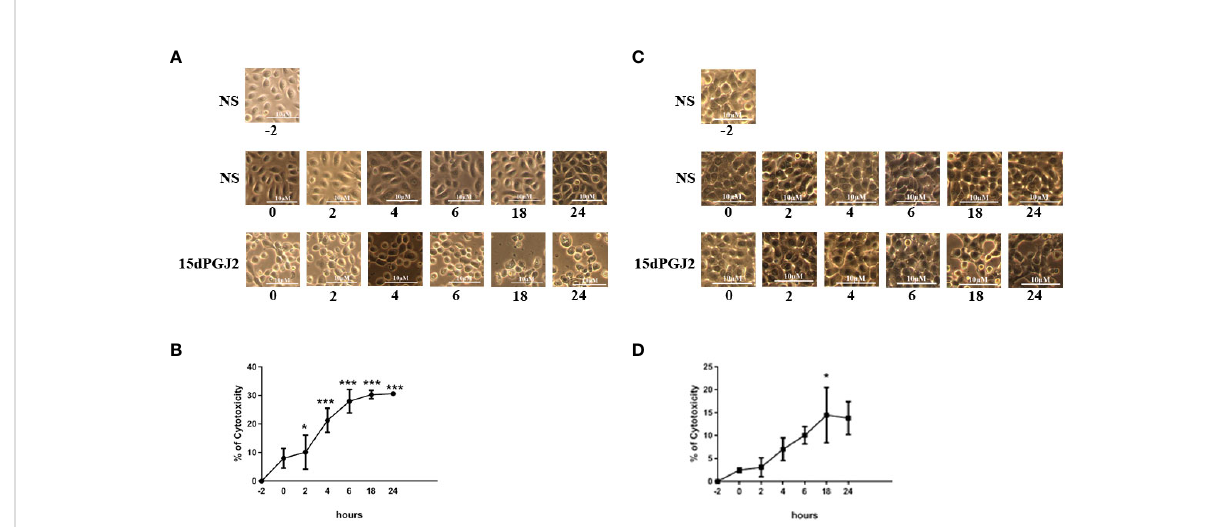
FIGURE 10 Effect of 15dPGJ2 on cell viability in vaginal and amnion epithelial cells. VECs and AECs were incubated with or without 32 m M of 15dPGJ2 and the morphology of the cells were assessed by bright fi eld light microscopy at -2, 0, 2, 4, 6, 18 and 24 hours. 15dPGJ2 or vehicle control was inserted in the corresponding wells at -2 timepoint following image and supernatant capture. The culture medium at each time point was used to detect cell viability using the MTT assay. The morphology of VECs changed from a healthy polygonal shape to an abnormal round shape compared to the control (A) . The effect of 15dPGJ2 on cell viability was detected as early as 2 hours ( p < 0.05), and a steady change was seen at 4, 6, 18 and 24 hours ( p < 0.001) (B) . In AECs, the morphological shape of the cells started to change from an ovoid, slab stone- and cobblestone-like pattern to a stretched star-like pattern at 18 hours compared to the control (C) . The cell viability of amnion epithelial cells was signi fi cantly changed by 18 hours in 15dPGJ2 treated cells ( p < 0.05) (D) . * p < 0.05, *** p < 0.001, NS non signi fi cant. n = 3. Data are presented as mean ± SEM.